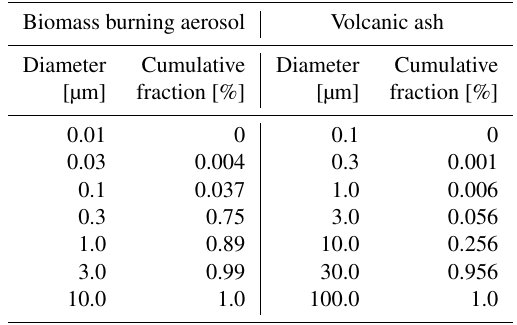
Table 1. Cumulative aerosol size distributions for BBA and vol- canic ash according to Hobbs et al. (1991), Maryon et al. (1999) and Petzold et al. (2007), used in the NAME simulations. Biomass burning aerosol Volcanic ash Diameter Cumulative Diameter